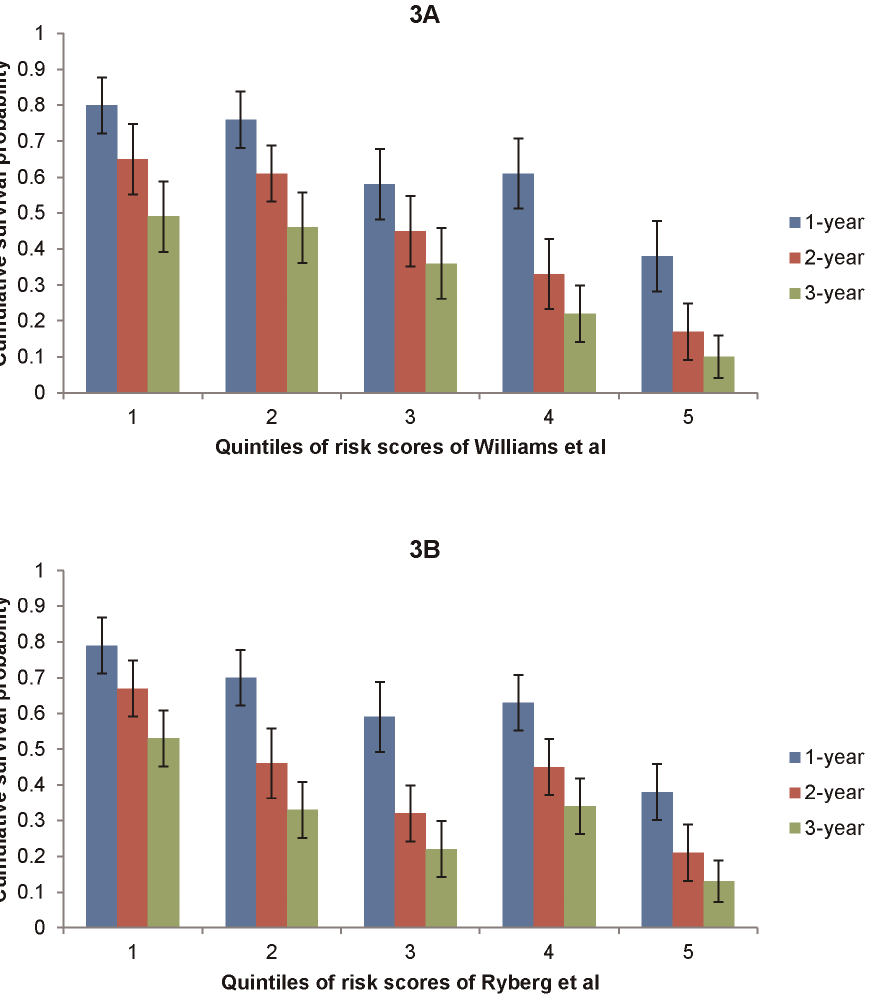
Figure 3. 1-, 2- and 3-year cumulative survival probability for different risk groups. Risk groups were defined by quintiles of risk scores of Williams et al.’s and Ryberg et al.’s model. 1 st quintile is the group with the highest predicted survival probability and 5 th quintile is with the lowest predicted survival probability.